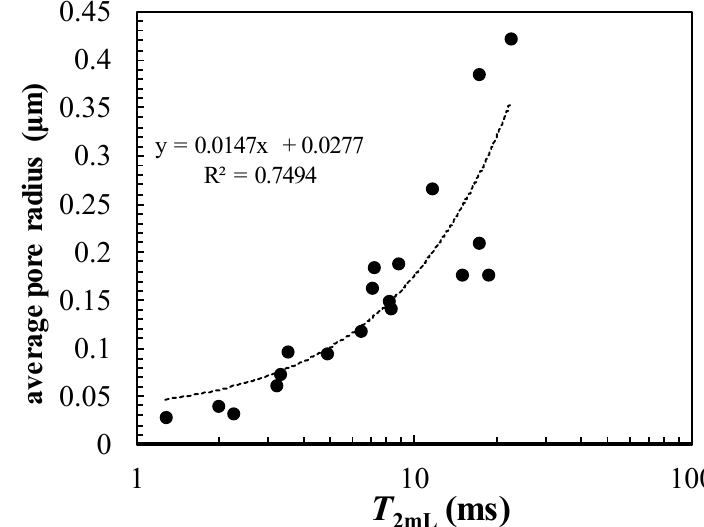
Figure 5. The relationship between average pore radius r and T 2ML of 19 core